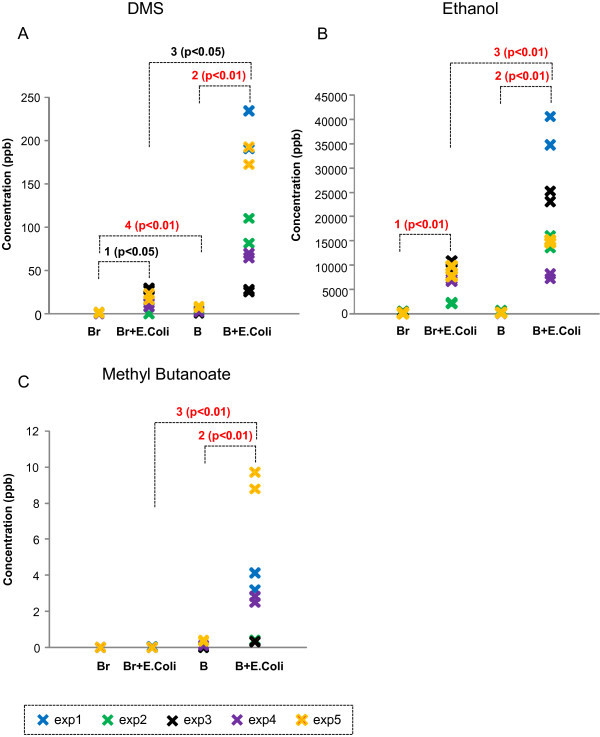
Representative patterns of VOCs in Category 1. (A) DMS, (B) Ethanol, and (C) Methyl Butanoate emission from 4 different conditions: broth only (Br), E. coli in LB broth (Br + E. coli), whole blood only (B), and E. coli-inoculated whole blood (B + E. coli). 1. significantly different between Broth only and Broth + E. coli; 2: significantly different between Blood only and Blood + E. coli; 3: significantly different between Broth + E. coli and Blood + E. coli; 4: significantly different between Broth only and blood only.